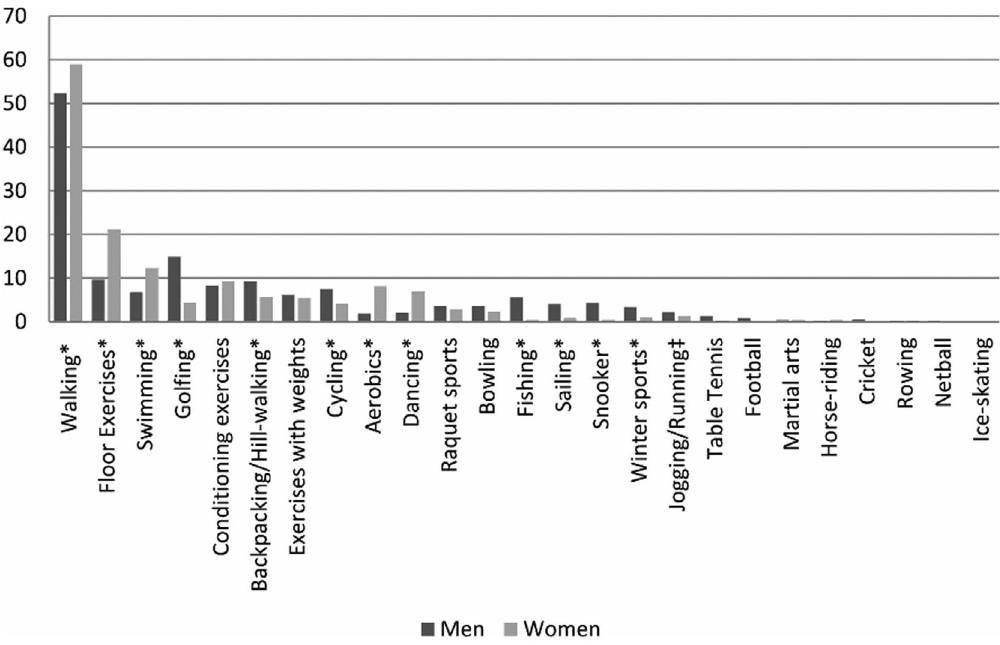
Figure 1. The percentage (%) of participants, (n 1 =2188) reporting sport and exercise activities on a regular basis ` , by gender. 1 Percentages reported are based on available n for each specific activity; ` ‘report of weekly participation in ‘x’ activity of minimum duration, 30 minutes per episode’. * p , 0.05; ` p , 0.10: test of gender difference. Note : No difference by gender existed for exercises with weights and conditioning exercises either in the last year or report of regular participation; N’s were not robust to examine football, horse-riding, cricket, ice- skating, martial arts, and netball by gender due to low number of participants reporting these activities. Activity order was determined by the most frequent activity in both genders combined. Top ten most frequently reported activities by gender (where ‘1’ indicates most frequently reported activity): Men : 1) walking for pleasure, 2) golfing, 3) floor exercises, 4) backpacking/hill-walking, 5) conditioning exercises, 6) cycling, 7) swimming, 8) exercises with weights, 9) fishing and 10) snooker. Women : 1) walking for pleasure, 2) floor exercises, 3) swimming, 4) conditioning exercises, 5) aerobics, 6) dancing, 7) backpacking/hill-walking, 8) exercises with weights, 9) golfing and 10) cycling.